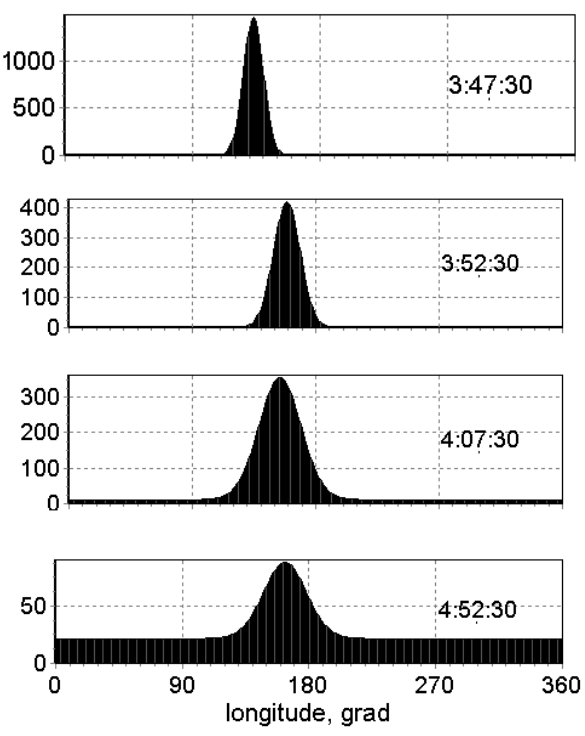
Fig. 15. Dynamic of the longitudinal distribution of the solar cos- mic ray flux at the Earth’s equator during the first 75min of the enhancement. Along the ordinate axis the flux of solar cosmic rays is plotted in pfu/MeV*10 5 .